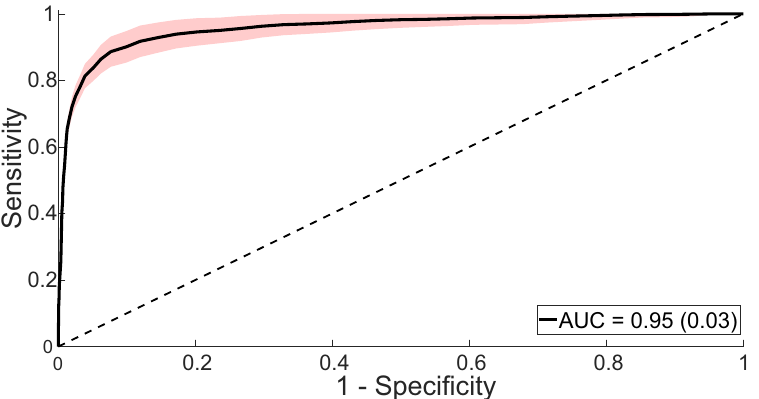
Figure 3. ROC curve obtained after 100-random splits for the proposed classifier. The solid black line represents the mean AUC performance obtained, while the red area represents the variability AUC interval (mean SD). ROC: Receiver Operating Characteristic; AUC: Area Under the